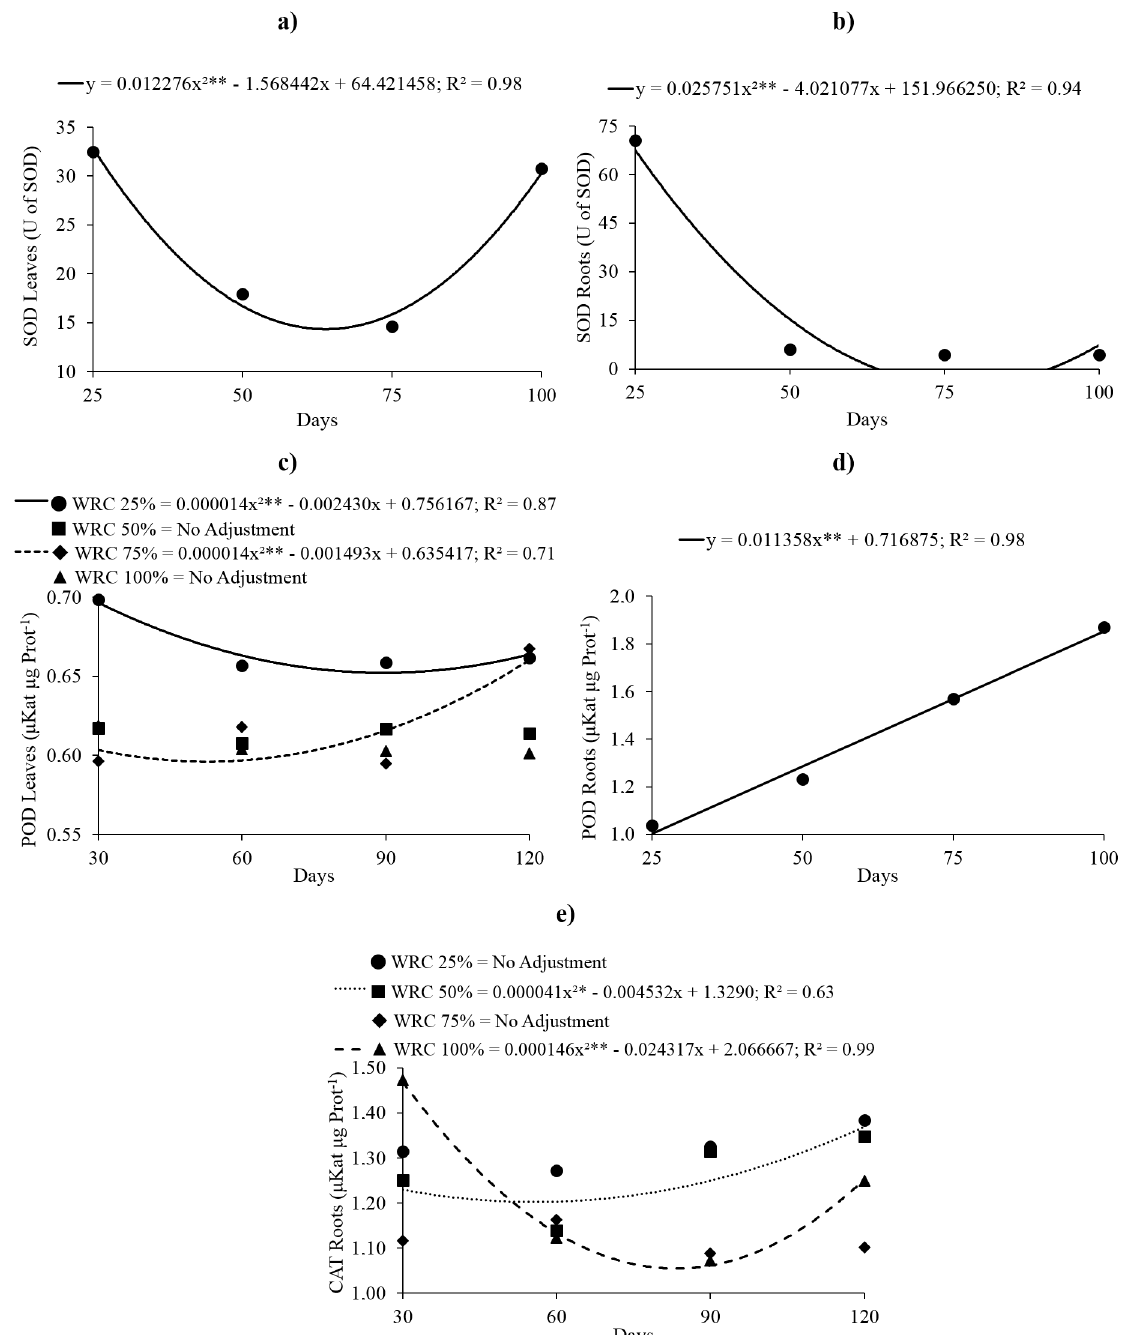
Figure 5 - Enzymatic activity of Superoxide dismutase in leaves - SOD ( a ) and roots ( b ); of Peroxidase in leaves - POD ( c ) and roots ( d ) and Catalase in leaves - CAT ( e ) in Copaifera langsdorffii Desf. depending on different water retention capacity (WRC) and